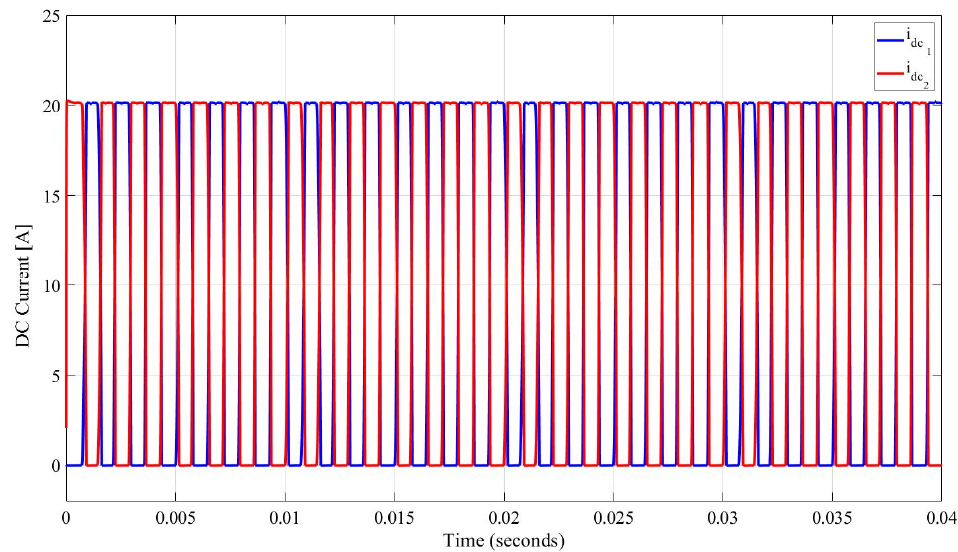
Figure 7. The DC current waveforms 𝑖 (cid:3031)(cid:3030)